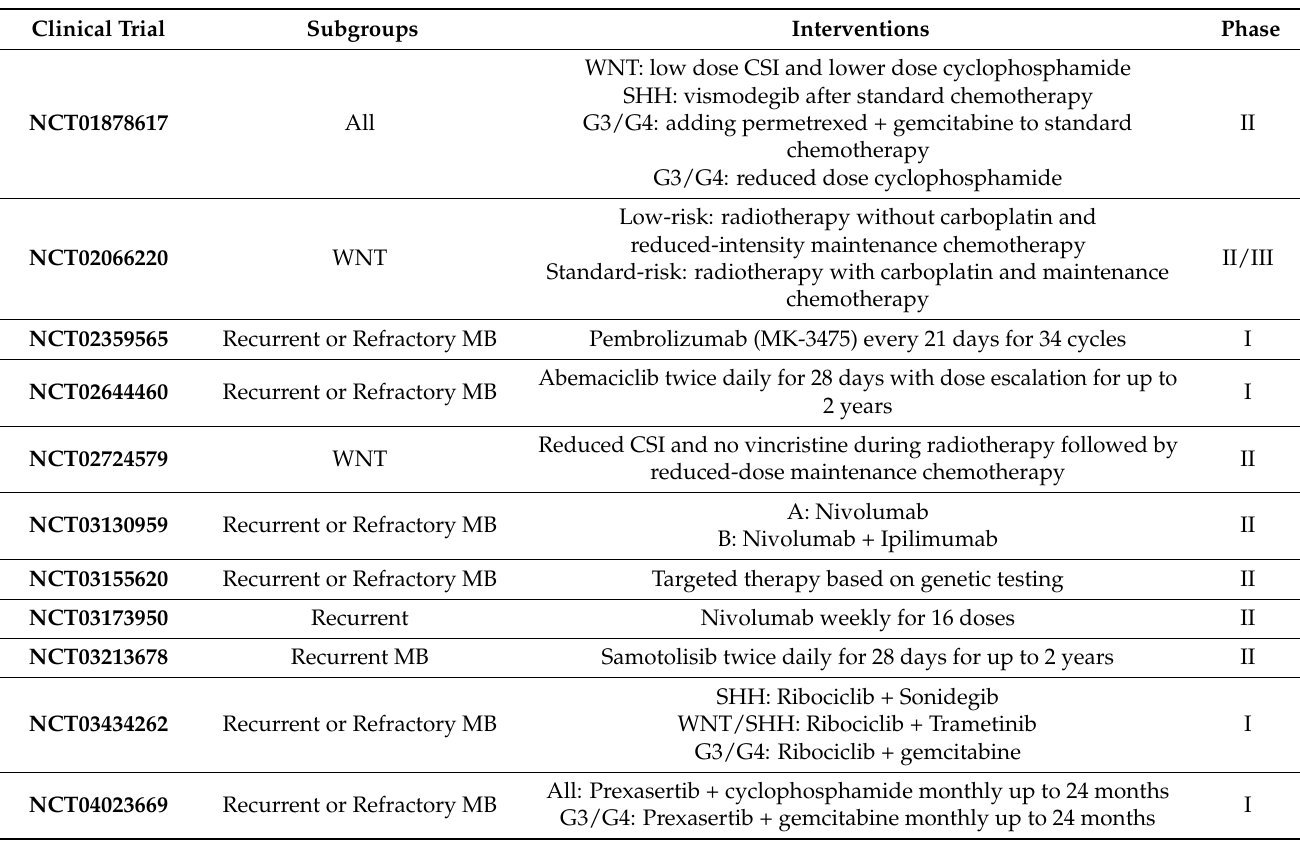
Table 3. Current clinical trials in